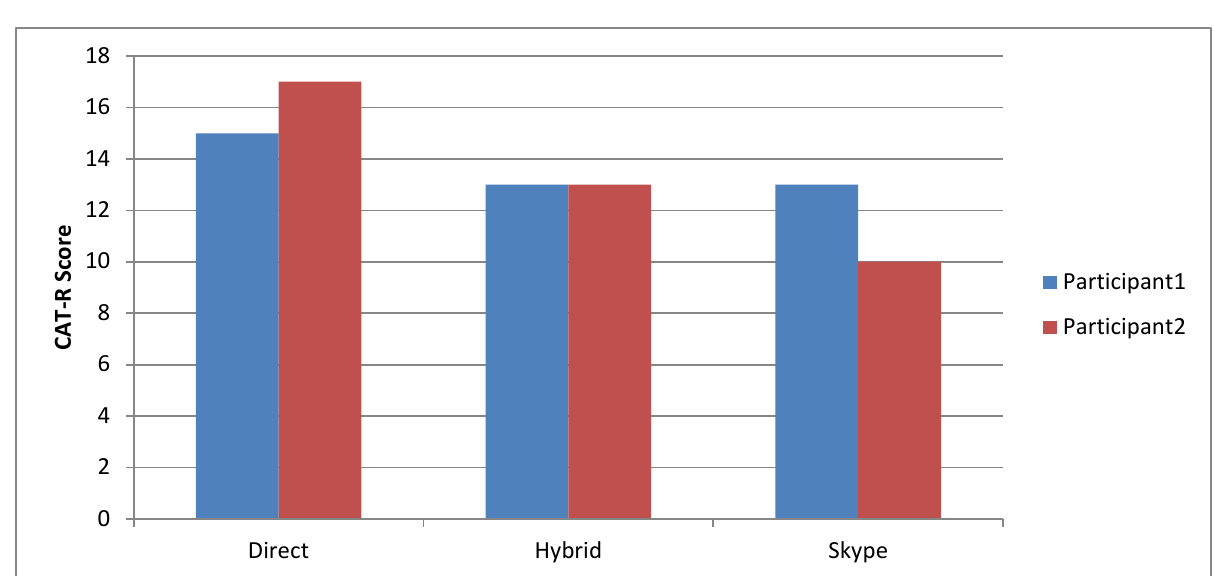
Table 1. Caregivers’ Perceptions of Telepractice Experience